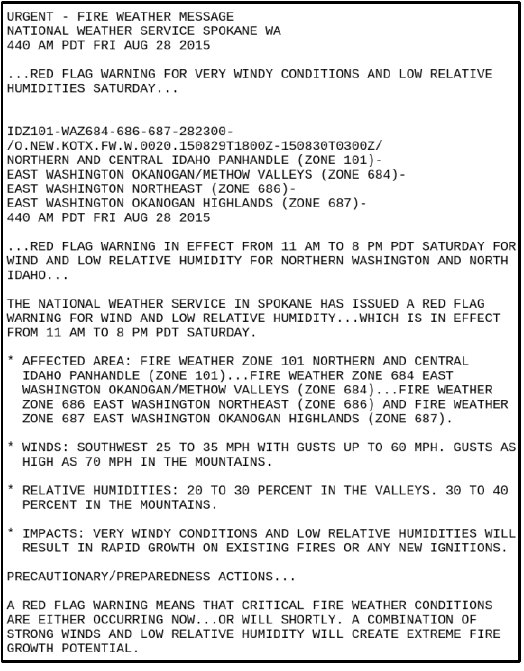
Figure 1. An example of a Red Flag Warning issued by the National Weather Service (NWS) Spokane forecast office for windy and dry conditions on 28 August 2015.